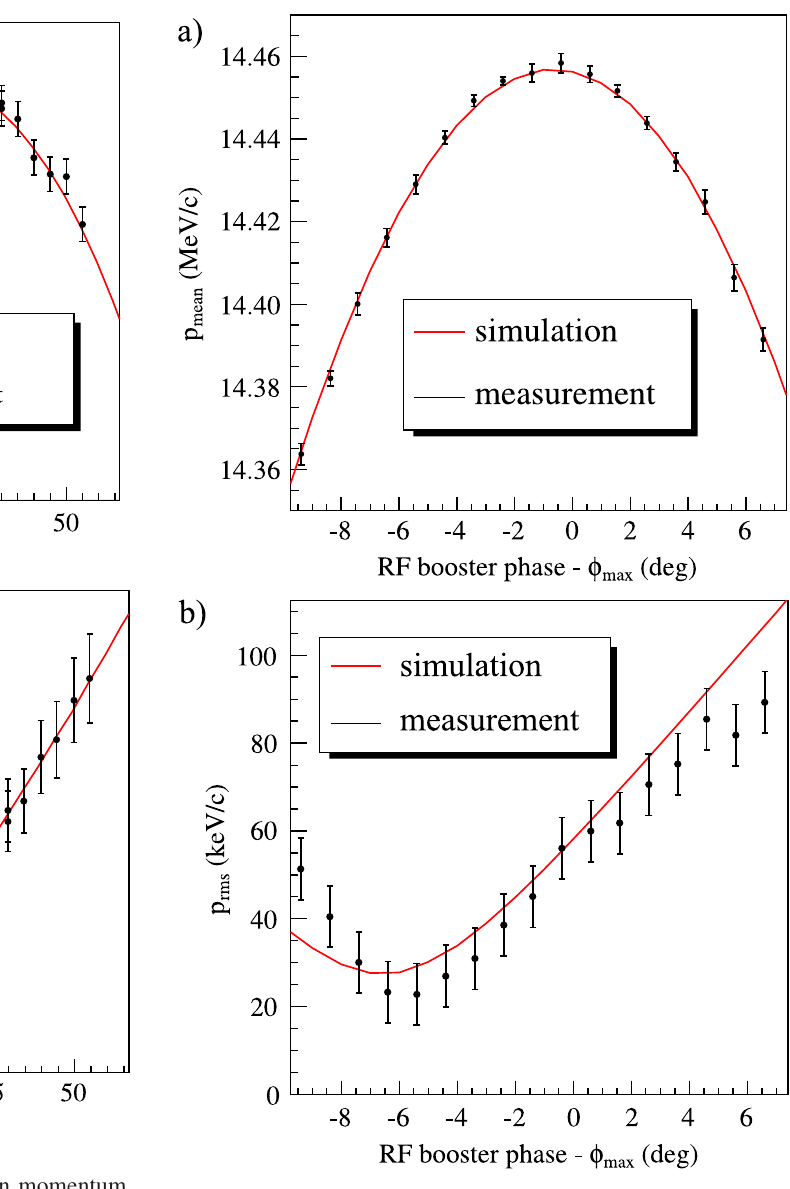
FIG. 25. (Color) (a) Mean momentum and (b) momentum spread after the booster measured for different booster phases at a gun phase with maximum energy gain. The solid line presents the results from ASTRA